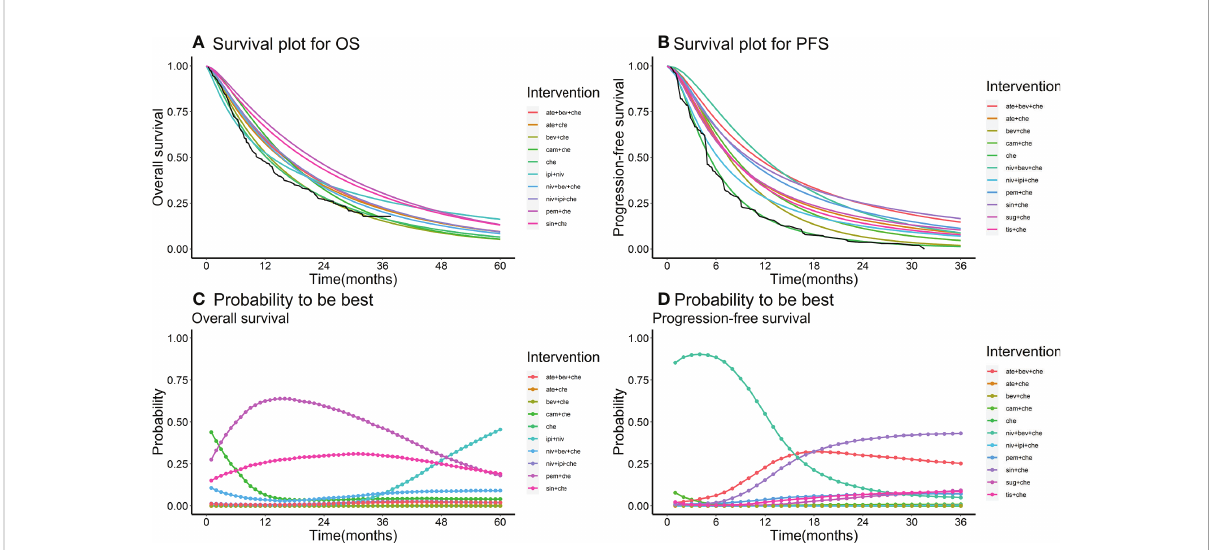
FIGURE 4 (A) survival plot for OS; (B) survival plot for PFS; (C) rank plot for OS; (D) rank plot for PFS. Survival plot and rank plot for overall survival (OS) and progression-free survival (PFS). The black line in the survival plots is the Kaplan – Meier (KM) curve of the reference chemotherapy. Probability is the probability of being the best treatment in terms of survival bene fi ts in each month from month 36 to month 60.